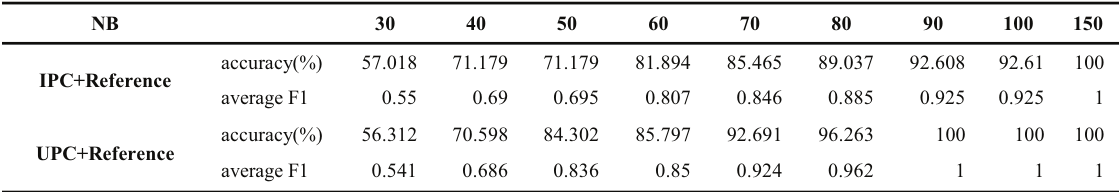
Table 5. Average F1 value for different attribute number when classifying patents based on IPC+ Reference and UPC+ Reference using Naïve Bayes.